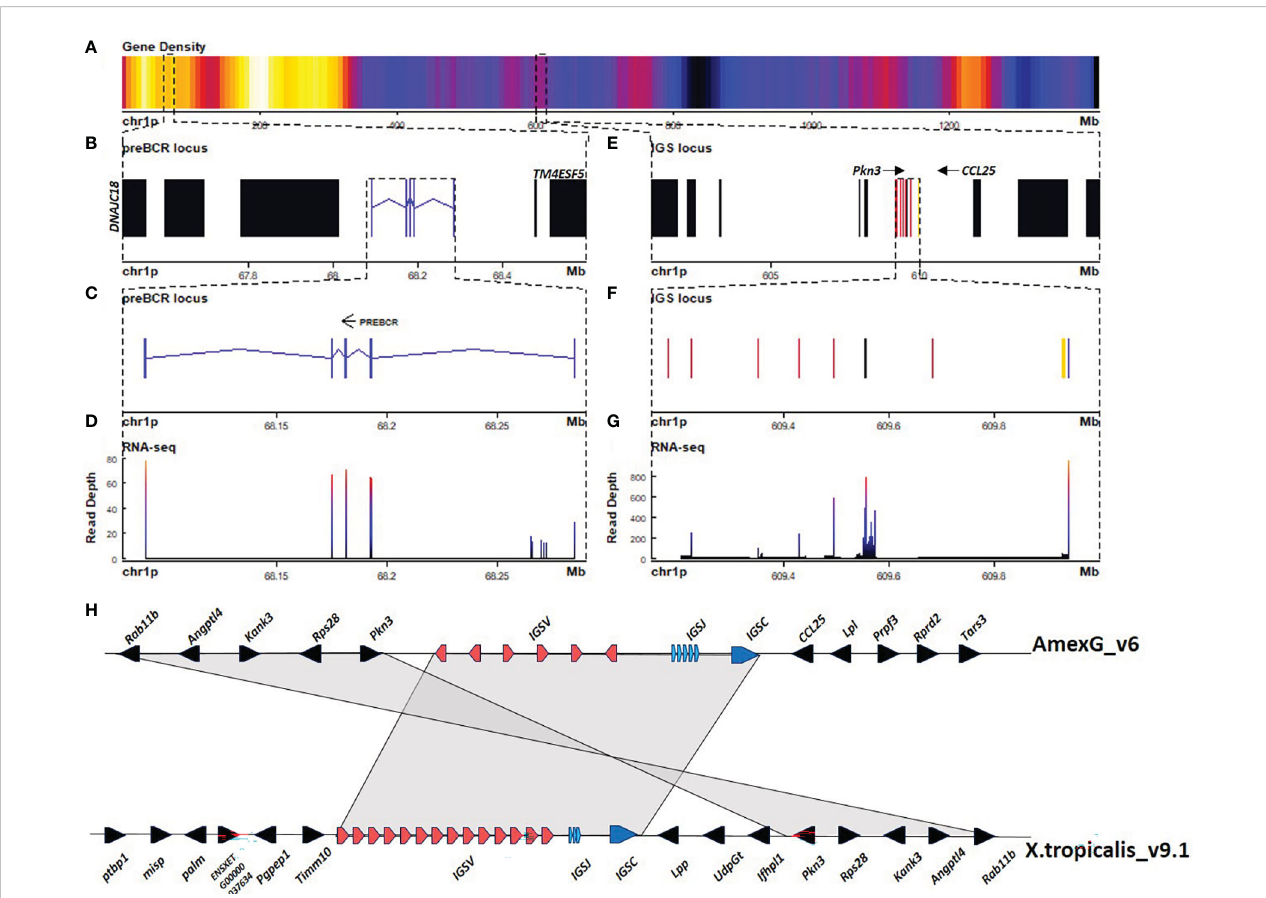
FIGURE 3 The sigma light chain locus is located in the centromeric portion of chr1p (609.1 - 609.2 Mbp). (A) Gene density plot of chr1p where the IGS and the putative surrogate light chain (SLC) loci are encoded (box). Dark blue colors indicate low gene density. (B) Zoom of the whole putative SLC locus (67.5 - 68.6 Mbp). Non-Ig genes (black) in proximal fl ank DNAJC18 and distal fl ank TM4ESF5 . Zoomed view of IGLC genes (blue). (C) Zoomed view (68.08 - 68.29 Mbp) of the putative SLC gene. (D) Spleen RNA-seq coverage histogram. (E) Zoom of the whole IGS locus (601 - 616 Mbp). Non-Ig genes (black) in proximal fl ank RAB11B gene and distal fl ank PRPF3 . (F) Zoomed view of IGSC genes (blue), IGSV genes (red) and IGSJ (yellow) (609.15 - 610 Mbp) (G) Spleen RNA-seq coverage histogram . (H) Schematic representation of Immunoglobulin sigma locus in A. mexicanum genome (v6) (chr1p:609 - 610 Mbp), and X. tropicalis (chr1: 82.1 - 82.22 Mbp). Color code as in A. X. tropicalis displays the canonical architecture, in which the V, J and C clusters are in the same orientation. Note that in A. mexicanum , IGSV gene orientation in axolotl is intercalated, which is atypical. Non-Ig genes in the downstream fl ank are different in A. mexicanum and at least the PRPF3 , RPRD2 and TARS3 genes are located in chr8 106.9 – 107.1 Mbp in X. tropicalis . Also, non Ig genes in the upstream fl ank correspond to the downstream fl ank in X. tropicalis . It is possible that this chromosomal con fi guration is correct, however it is also possible that the IGS locus may be inverted so that the downstream fl ank is syntenic with X. tropicalis . Not on